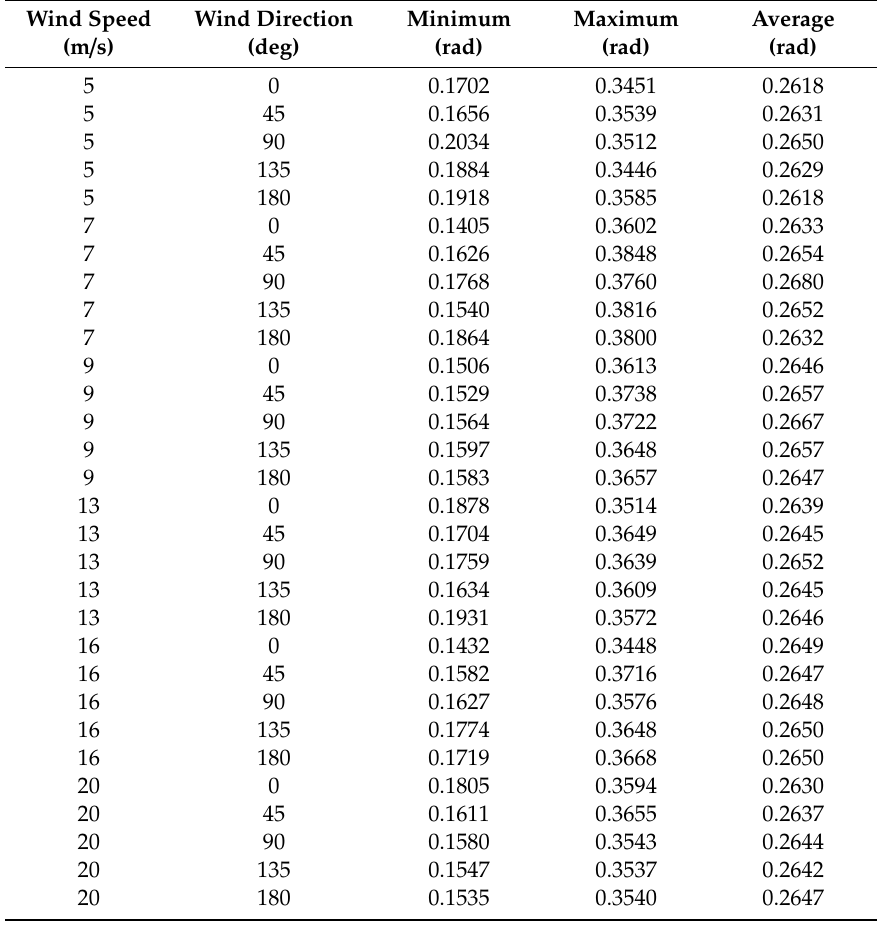
Table 5. Statistical results of the refraction angles of 1000 pulse spots.